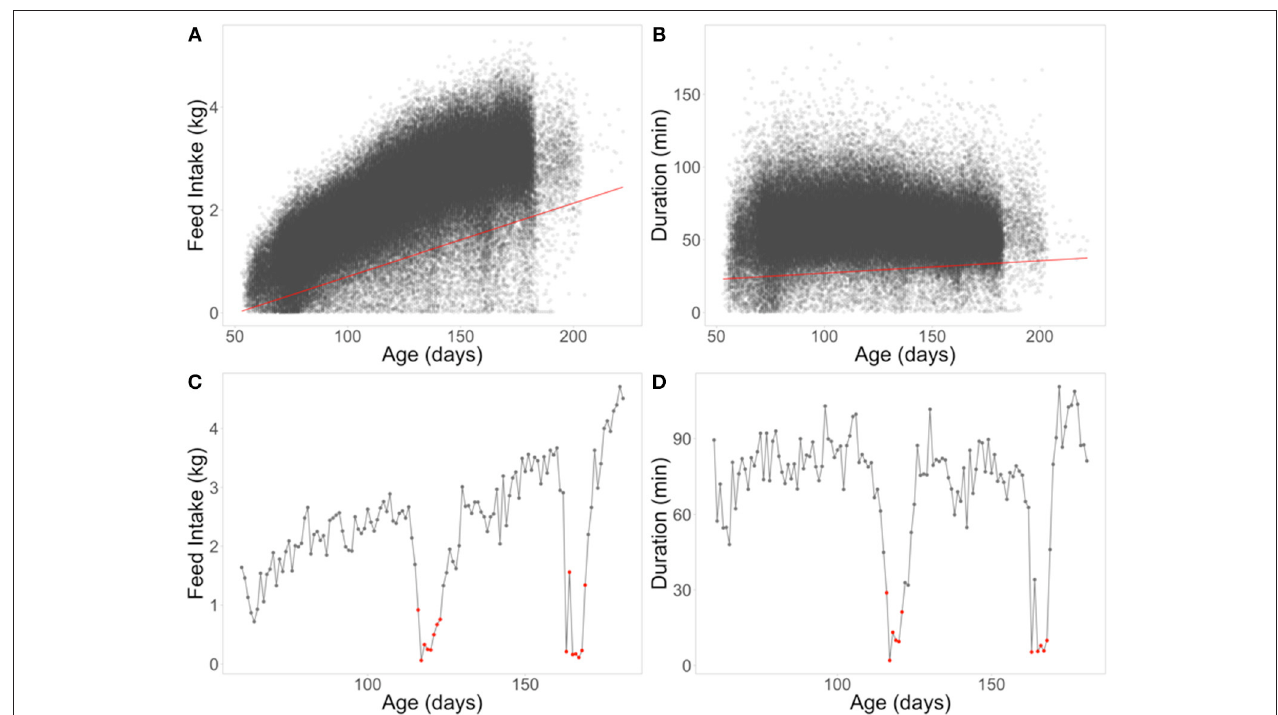
FIGURE 4 | Quantile regression (QR) at the 5% level for feed intake (A) and duration (B) . Example of classifying off-feed days for animal 0042 using QR FI (C) and QR DUR (D) in the lower panels. Red lines are the 5% QR for each FI (A) and duration (B) . Red dots represent off-feed days used to calculate the QR phenotypes (proportion of off-feed